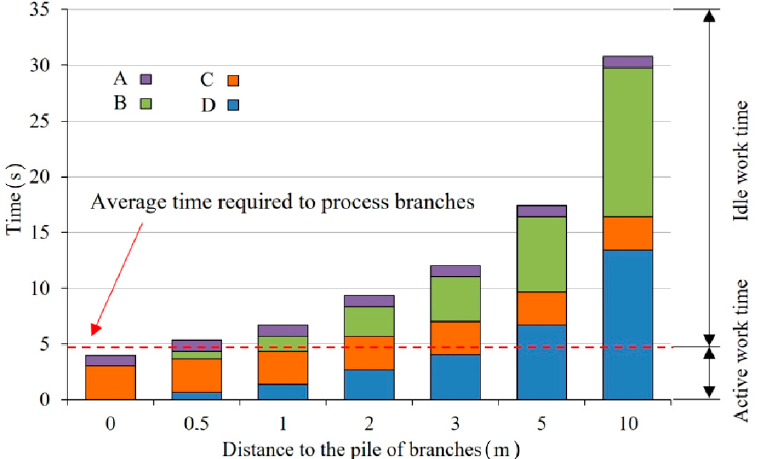
Figure 3. Theoretical delivery of branches time characteristic to the chipper by one operator